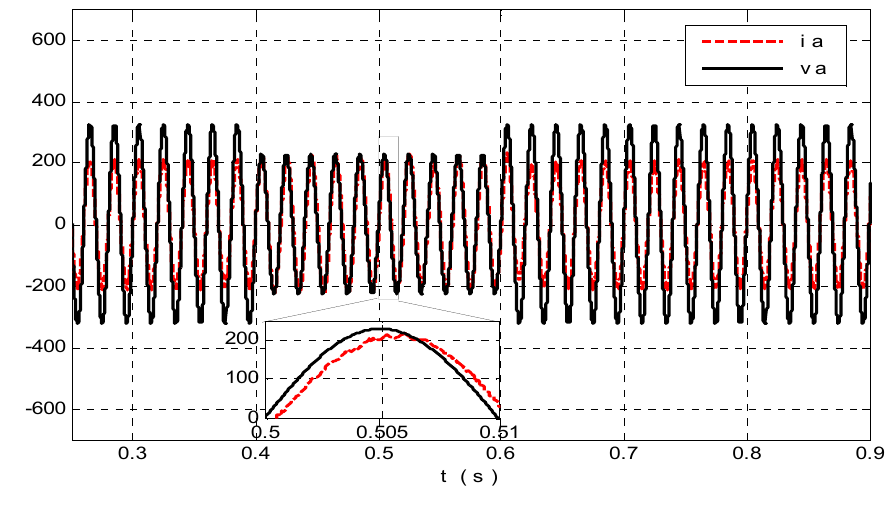
Electronics 2018 , 7 , x FOR PEER REVIEW